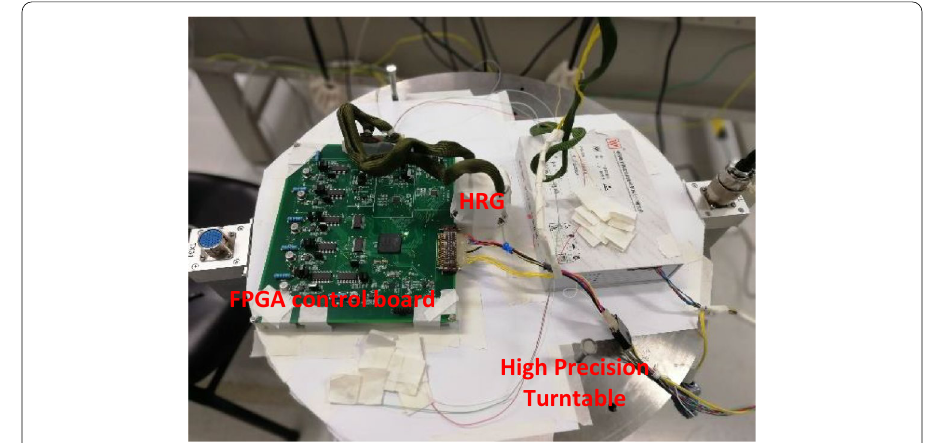
Fig. 4 The hardware experimental circuit and the WA mode of the